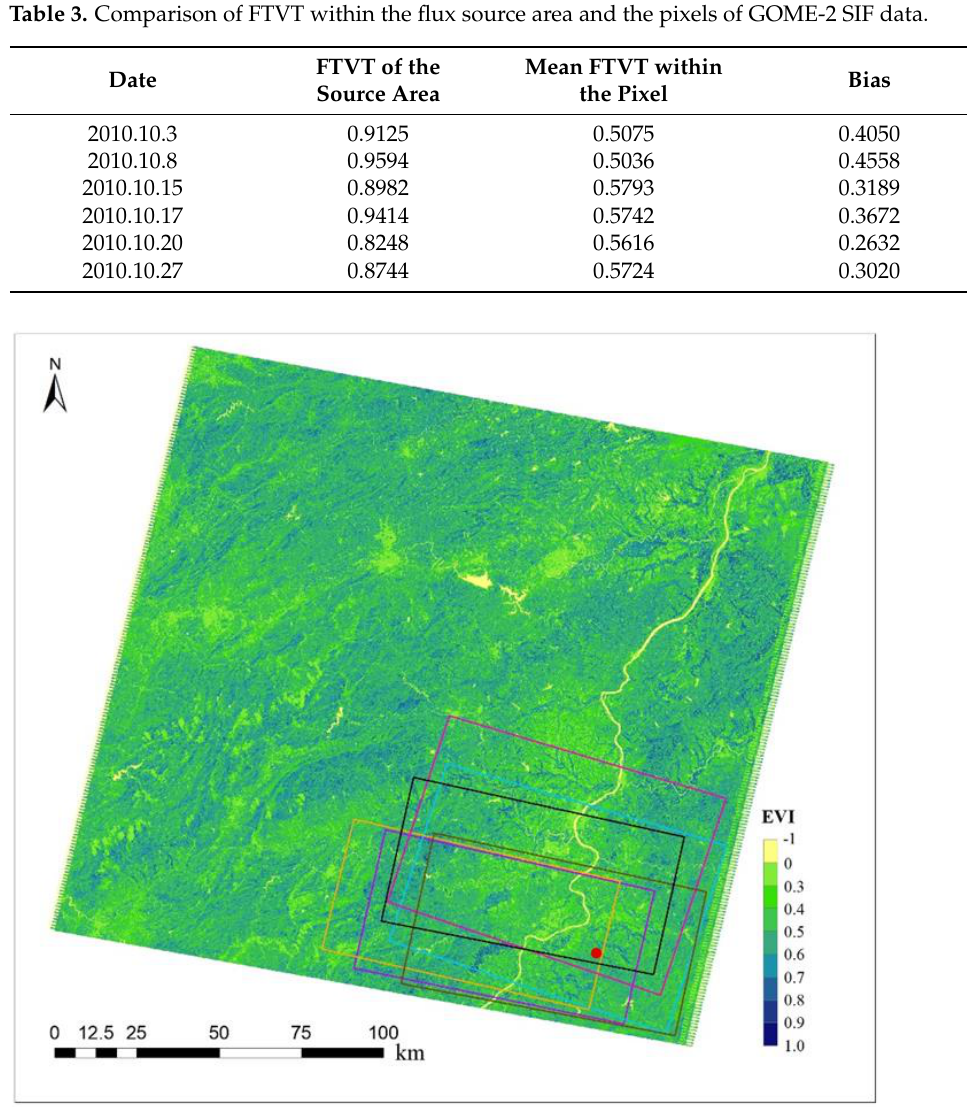
Figure 9. The location of the study site (red point) and the rectangular area is the solar-induced chlorophyll fluorescence (SIF) pixel (40 km × 80 km) of the Global Ozone Monitoring Experiment-2 (GOME-2) in the same period, and the background is an EVI image derived from Landsat TM, 4 th October 2010. It can be seen that the SIF pixel position shift of GOME-2 is large, and the value of EVI within each pixel is relatively different.